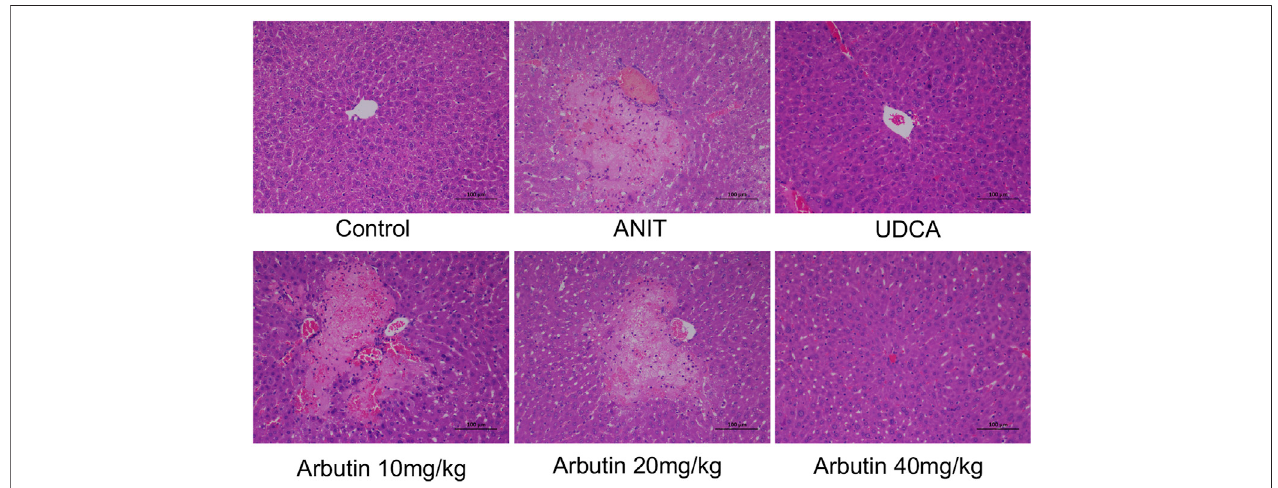
FIGURE 3 | Effects of arbutin on histological or morphologic variations in ANIT-induced cholestasis mouse. (I) Liver tissues by H&E stained ( × 200).